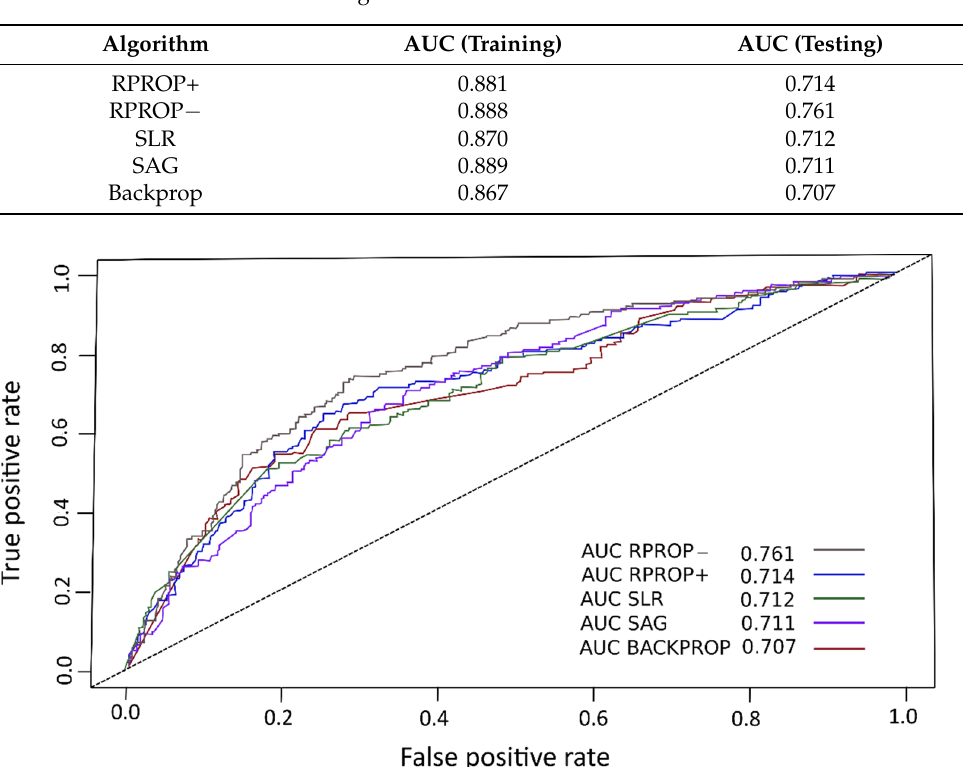
Table 8. Statistical evaluation parameters (training).